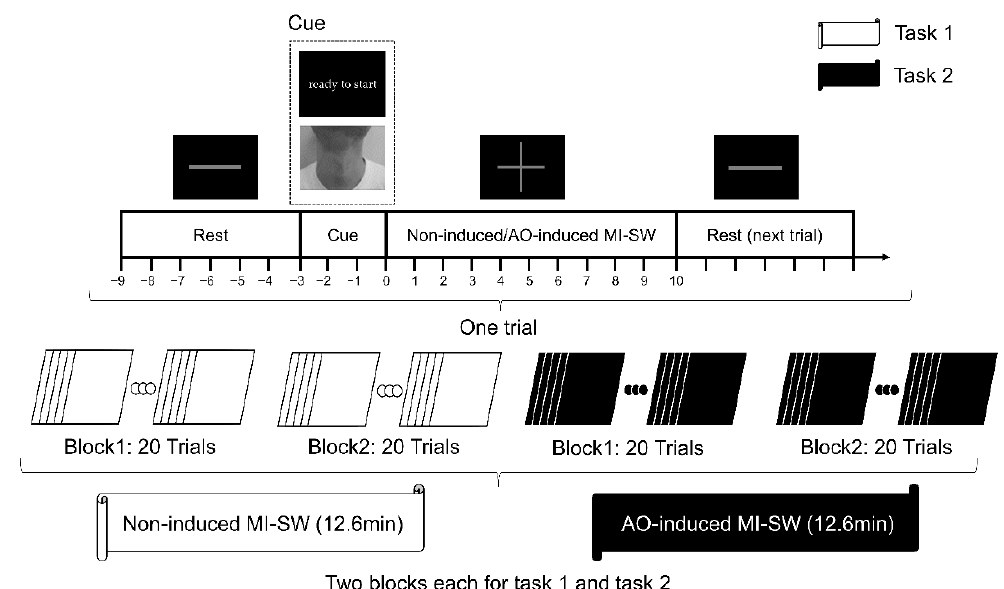
Figure 1. Flow chart for experimental paradigm. With the start of motor imagery of swallowing (MI-SW) task as the zero point, the baseline time window was − 5~ − 3 s, the induction cue time window was − 3~0 s, and the MI-SW time window was 0~10 s.